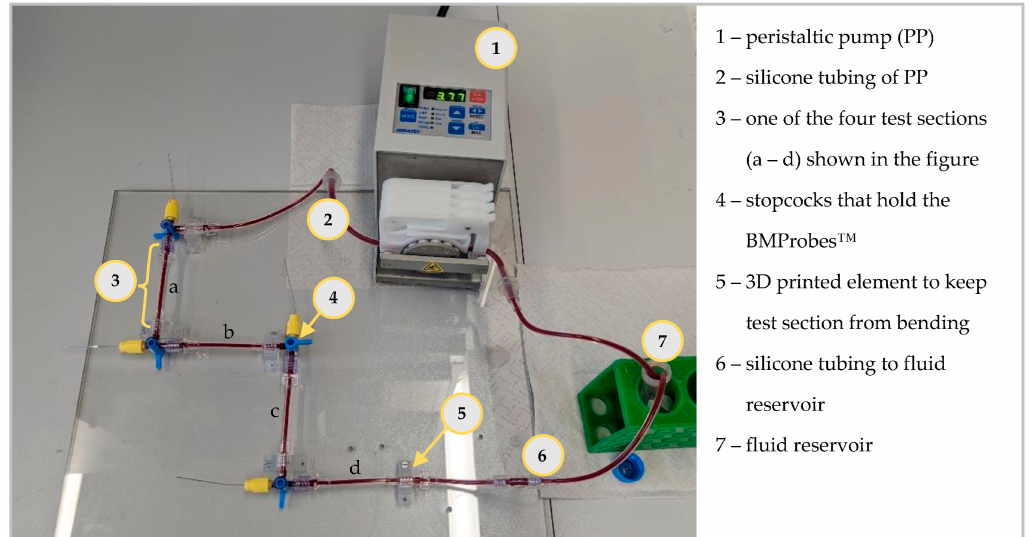
Figure 3. The developed flow system recreates the anatomical and physiological conditions of the median cubital vein. The PP pumps the blood from the fluid reservoir to the test sections using the silicon tubing of the PP. The number of test sections in the flow system can be increased. The 3D printed elements improve reproducibility by ensuring a straight test